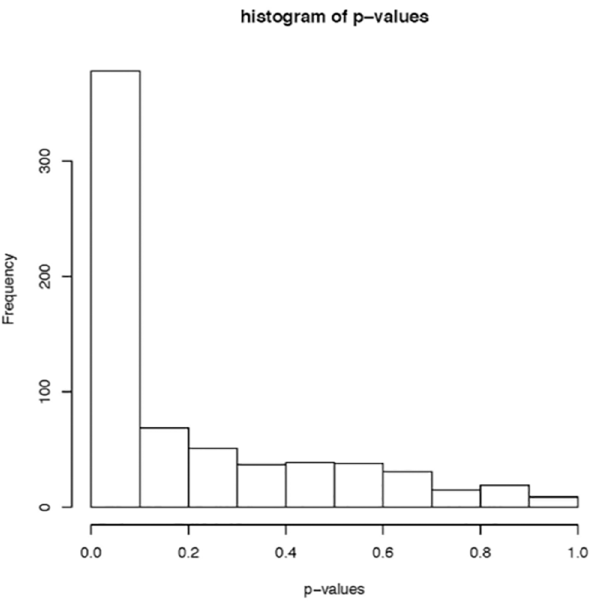
Fig 2. Histogram of p- values. A histogram displaying the distribution of p -values for jointly testing for an association between the clinical variables used to assess lung function and the levels of the analytes in the peptide profile. The large number of small p -values indicates that there is an association between the clinical data set and the peptide analytes in BALF.